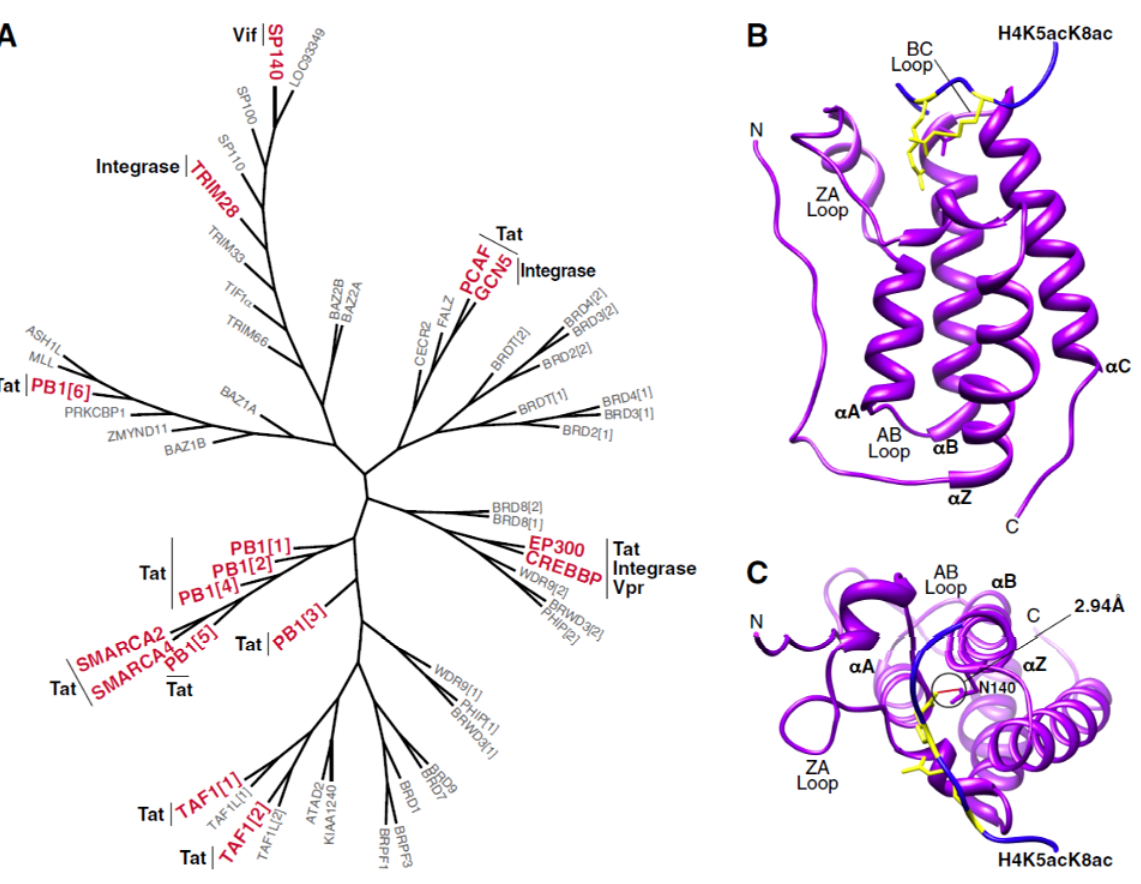
Figure 1. The human bromodomain family. ( A ) Phylogenetic tree of 57 human bromodomains. Those bromodomain-containing proteins that have been shown to interact with HIV proteins are denoted in red with the corresponding viral factor indicated alongside. Phylogenetic trees were generated using Seaview v4.4.1 with individual bromodomain sequences obtained from [23]. ( B ) Structure of the first bromodomain of BRD4 (purple) in complex with a diacetylated histone peptide (blue). Histone acetyllysine residues are shown in yellow. Structural representations in ( B , C ) were rendered using Chimera (UCSF) with PDB: 3UVW ( C ) Top view of interaction between first bromodomain of BRD4 and a diacetylated histone peptide. The hydrogen bond between the canonical bromodomain asparagine residue (N140 in BRD4) and the histone acetyllysine residue is shown in red with an estimated length of